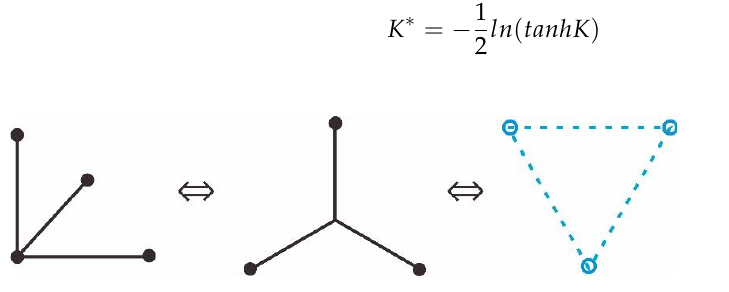
Figure 3. Equivalence between three interactions in the AMC model and those in a star lattice and the duality to a triangular lattice.